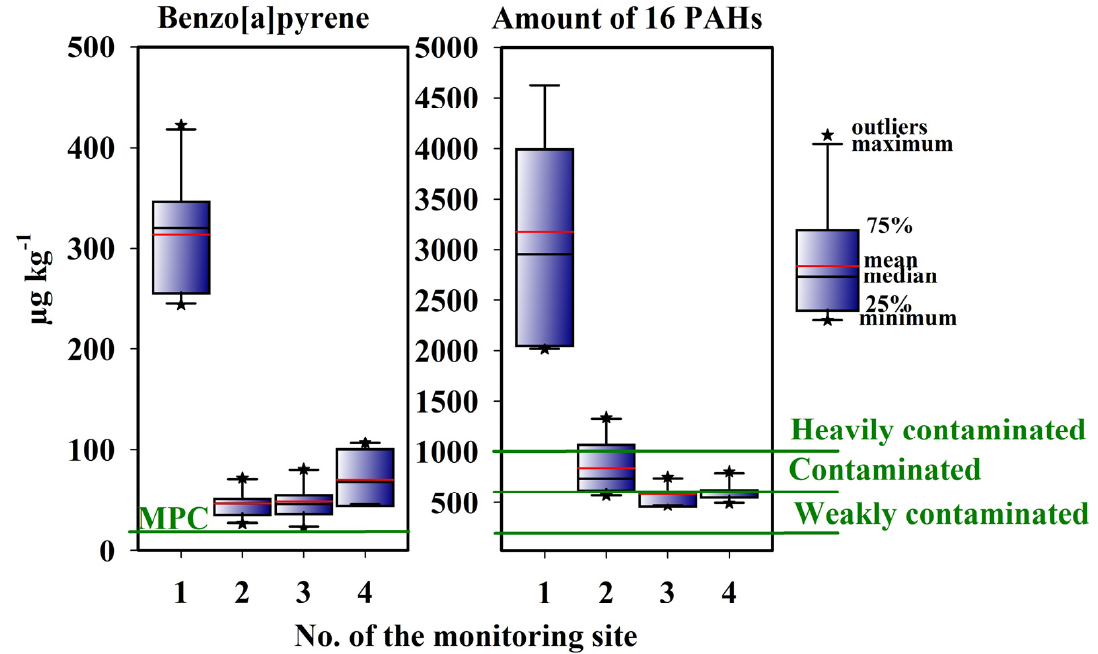
Figure 4. The content of benzo[a]pyrene and the total amount of 16 priority PAHs in the soils of agricultural fi elds located near the power station over a 10-year monitoring period. *—outlier.